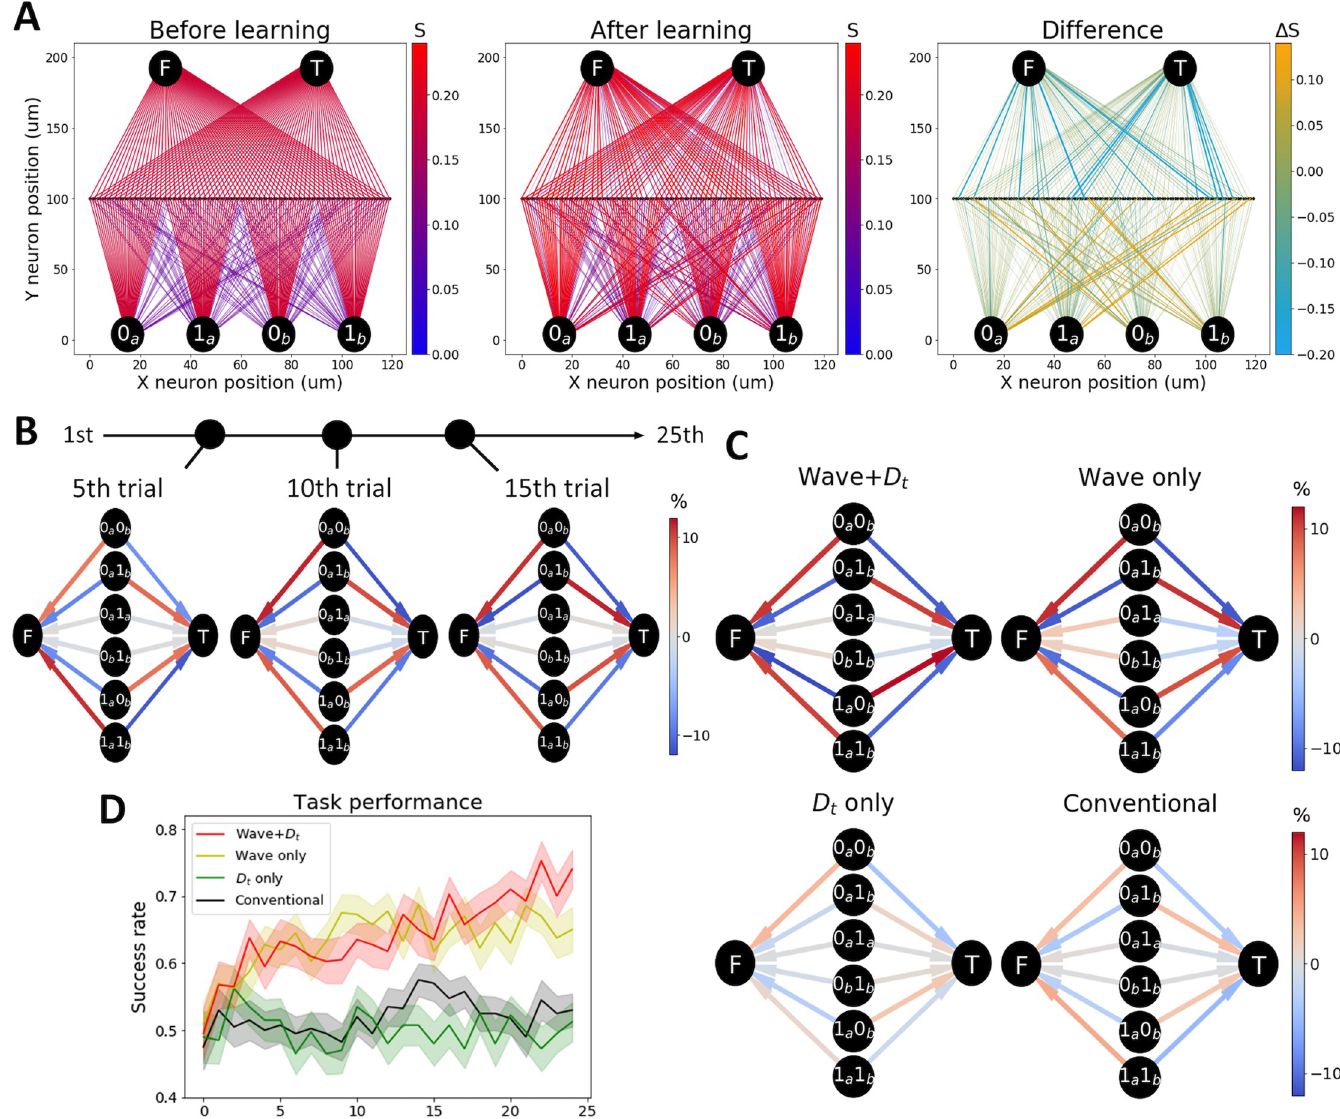
Fig 4. Wave propagation is useful for learning a nonlinear function. (A ) A successful example of synaptic weight change. The Initial condition (Left), the last condition (Middle), and the difference (Right). Each middle layer neuron receives a strong synaptic weight and a weak synaptic weight from stimulated neurons and sends an output to T or F. The success rate is initially at the chance level. (B) The averaged synaptic weight difference between each middle layer neuron projecting to T and F is plotted at the 5 th , 10 th , and 15 th trials. Each path strength is calculated as a product of the averaged synaptic weight from stimulated neurons to middle layer neurons and middle layer neurons to a target neuron. Percentage changes in averaged synaptic weight are shown in color. (C) The same plots as (B) at the last trial (the 25 th trial). Wave condition (top column) successfully learns the correct paths, while no-wave condition (lower column) fails. (D) The success rate of the XOR task. Wave conditions (red & yellow) shows better results than no-wave conditions (green &